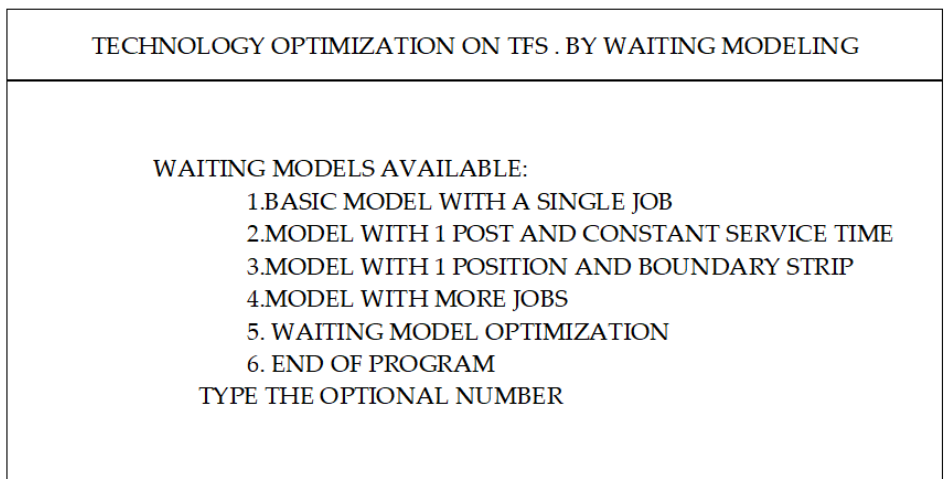
Figure 4. The first communication screen.